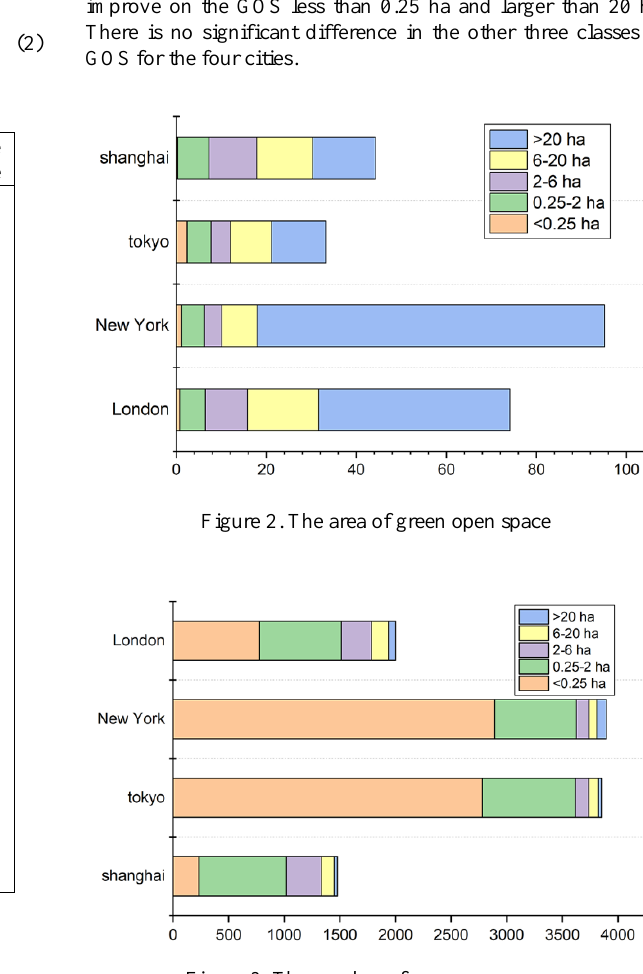
Figure 3. The number of green open space